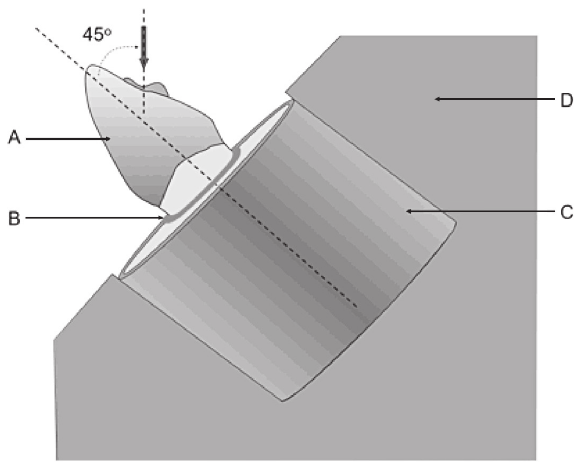
Figure 2- Schematic drawing of the specimen mounted in an acrylic resin block; (A) metal crown; (B) silicon-simulated periodontal ligament; (C) resin block; (D) metal device. Arrow indicates 45° angle of load applied to prepared